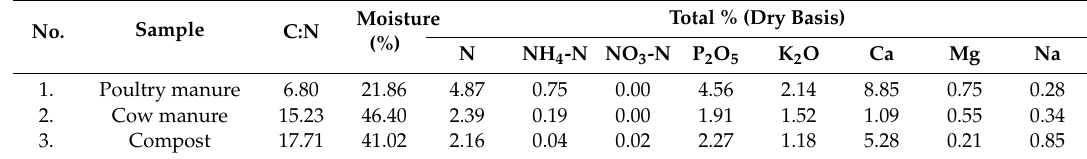
Table 2. Chemical compositions of poultry manure, cow manure and